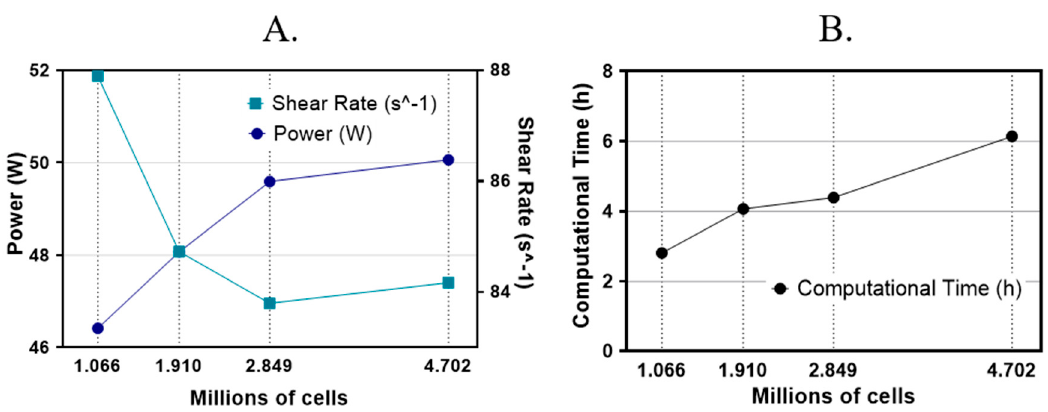
Figure 3. Mesh independence for: ( A ) power ( • ) and shear rate ( (cid:4) ); and ( B ) computational time on Figure 3 . Mesh independence for: (A) power ( ● ) and shear rate ( ■ ); and (B) computational time on Brunswick Bioflo / CelliGen 115 Brunswick Bioflo/CelliGen 115 bioreactor.